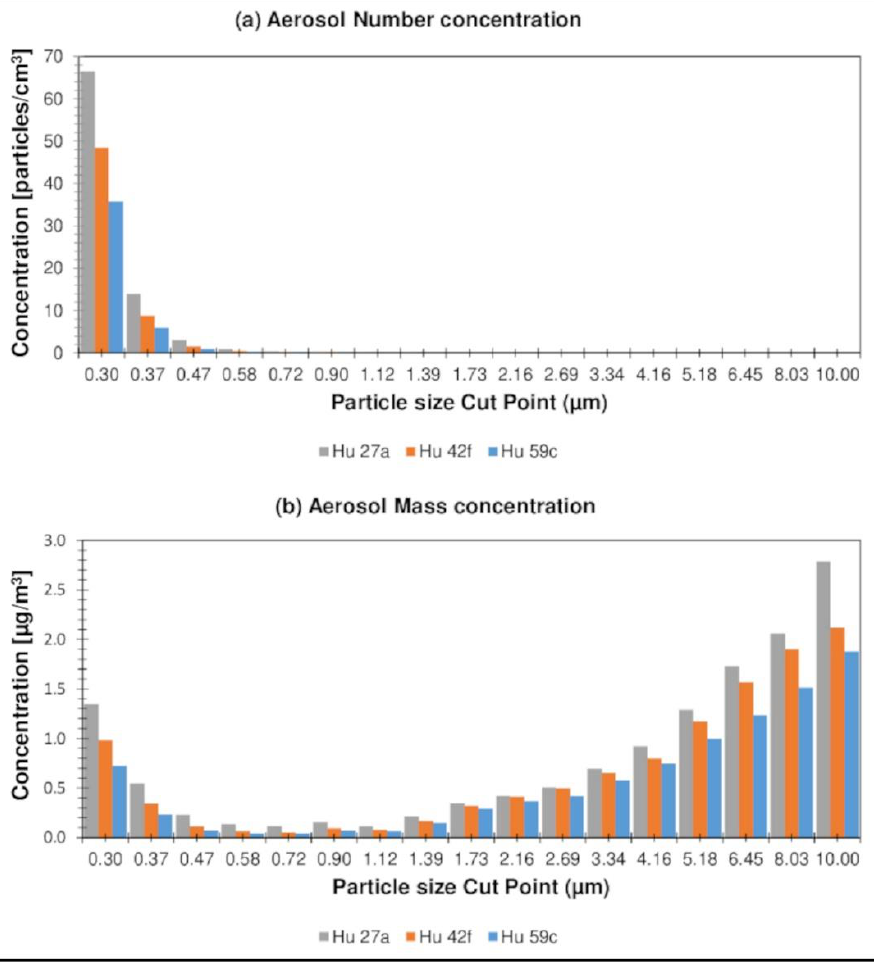
Figure 7. Aerosol number ( a ) and mass concentrations ( b ), taking into account the distribution of Figure 7. Taking into account the distribution of aerosol particle diameters, for Nemoral Scots aerosol particle diameters, for Nemoral Scots pine forests. pine